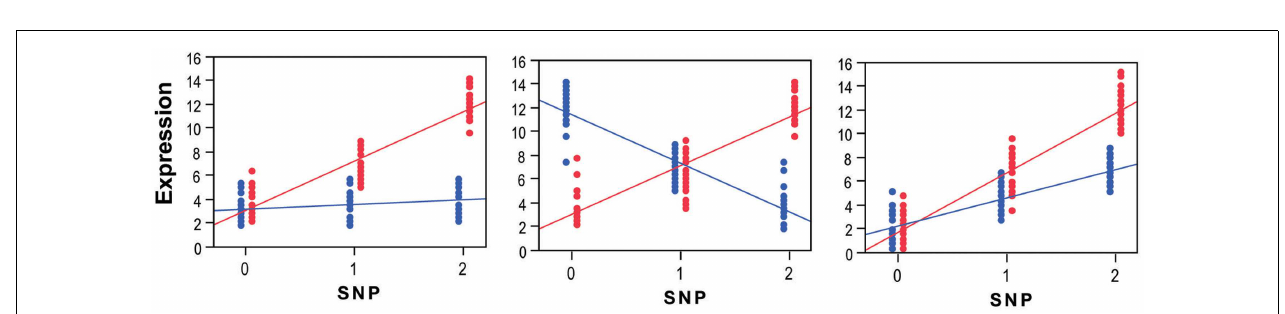
are scarce. Illuminating the mechanistic black box leading from genes to disease by characterizing variation at each – omics level and by capitalizing on the advantages and power gained from the use of endophenotypes holds the promise to address this major shortcoming in modern human biology.